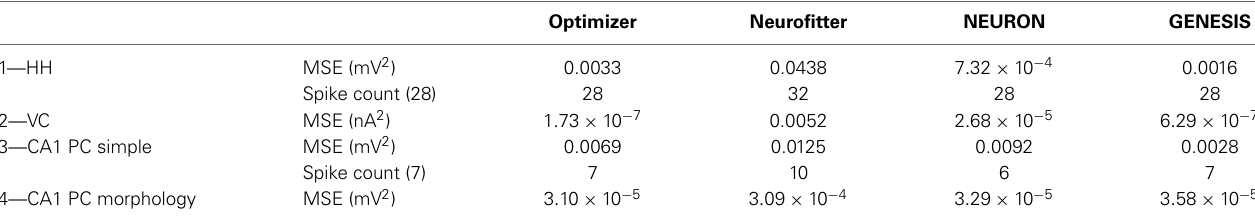
Table 1 | Comparison of the error in the best-fitting solution of different optimization software tools on the five problems defined in the Use cases